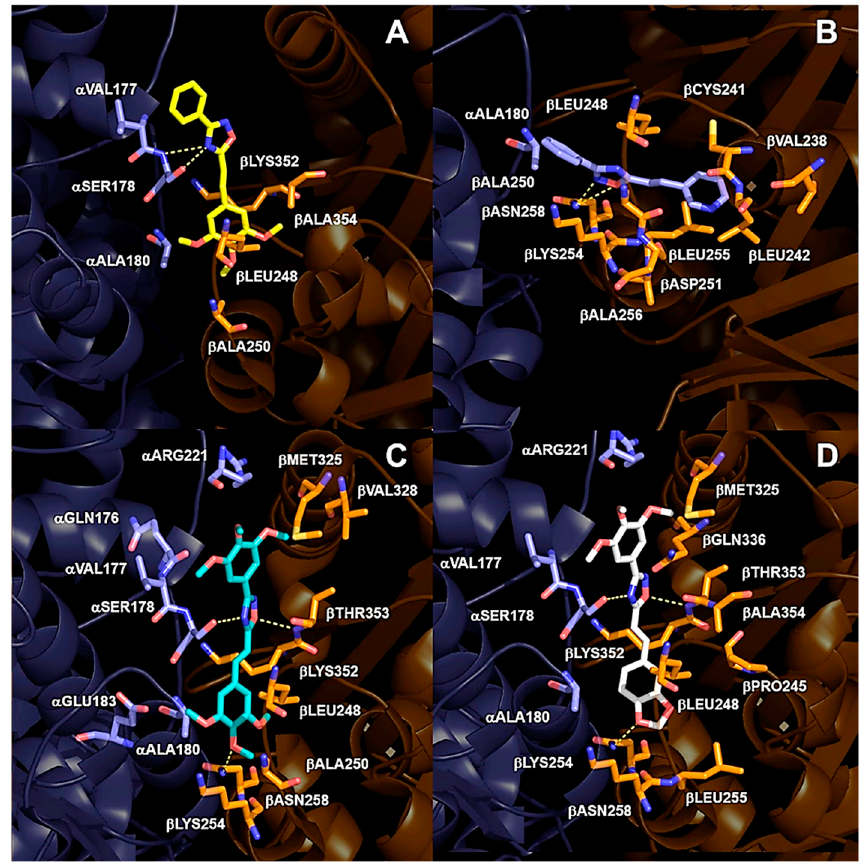
Figure 5. Best docking poses at CBS ( α and β monomers of bovine tubulin in purple and orange, respectively) obtained for compounds 12 ( A , yellow carbon atoms), 15 ( B , purple carbon atoms), 23 ( C , cyan carbon atoms), and 24 ( D , gray carbon atoms). Hydrogen bonds are in dashed yellow lines. Hydrogen atoms have been omitted for better visualization. Table 5. Comparison of the main interacting residues of representative compounds observed by molecular docking and the binding mode of colchicine in the crystal structure of tubulin dimer.